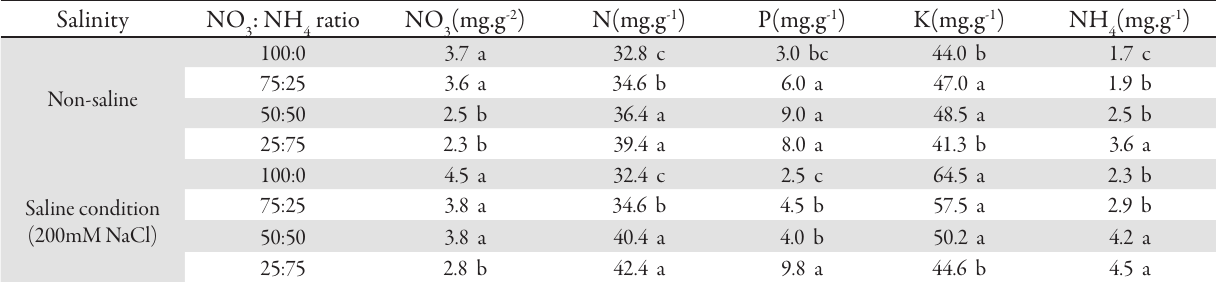
Tab. 3. The effects of salinity and NO3: NH4 ratio on the concentration of mineral nutrients